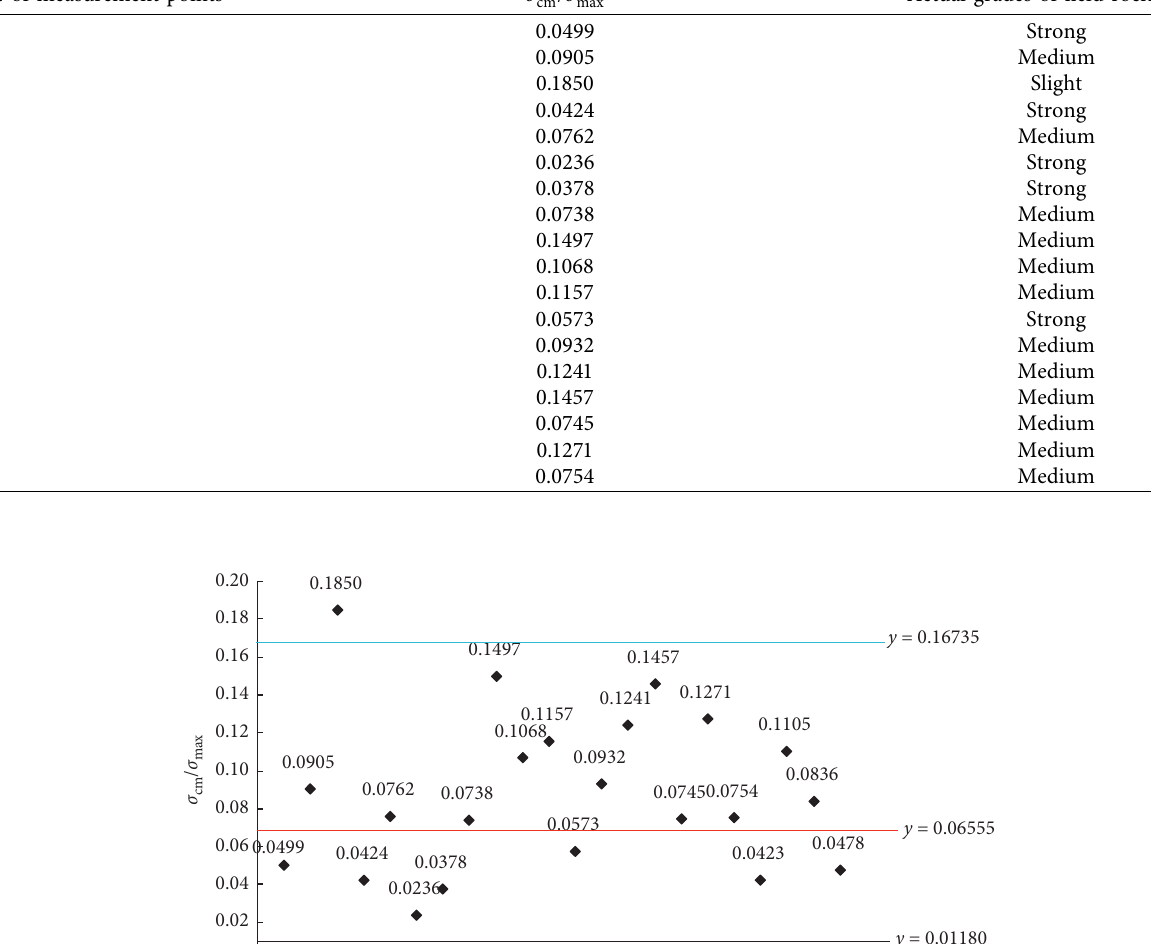
Table 7: Estimation results of the ratio of σ